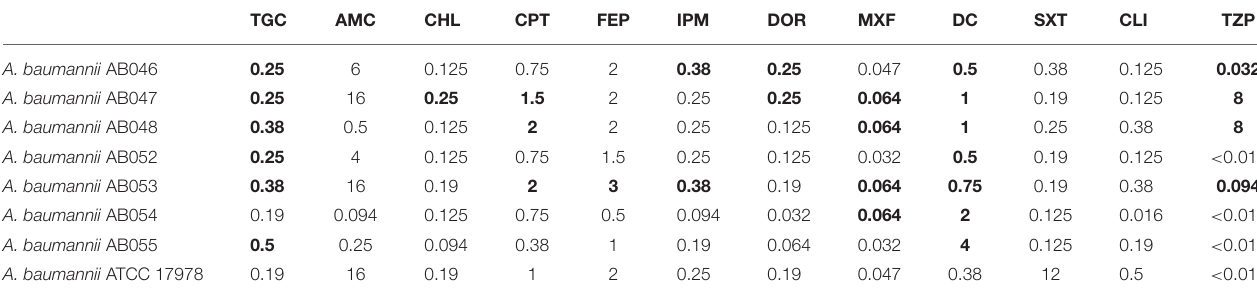
TABLE 3 | Antibiotic susceptibility of A. baumannii isolates as determined by E -test (mg/L). TGC AMC